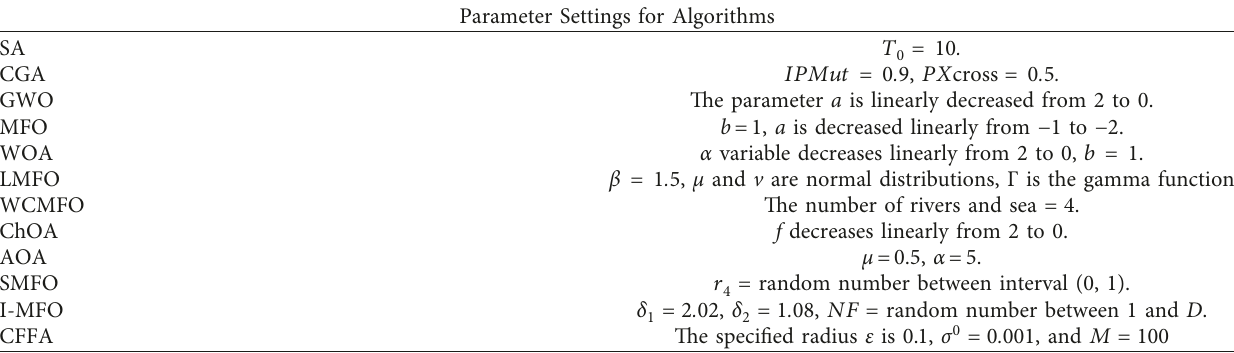
Table 2: The CFFA and other competing algorithms ′ parameter settings. Parameter Settings for Algorithms